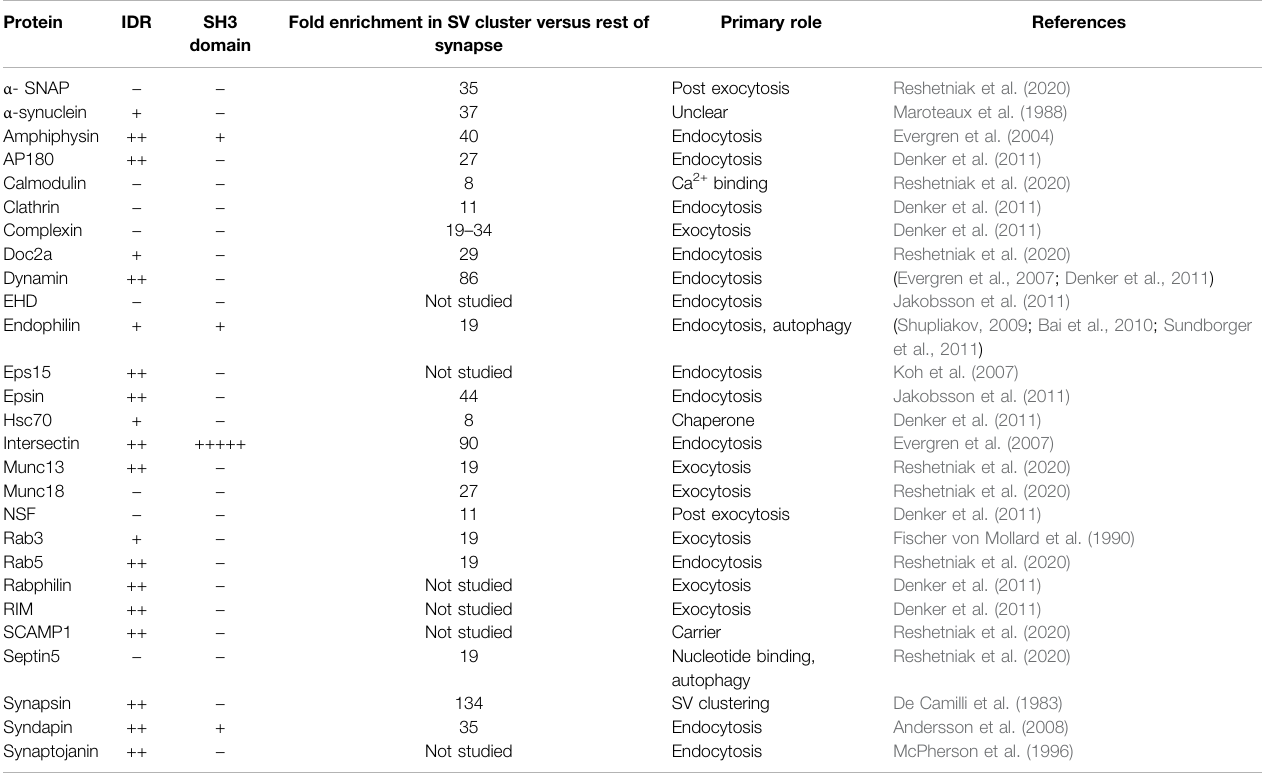
TABLE 1 | Properties of proteins enriched in the synaptic vesicle